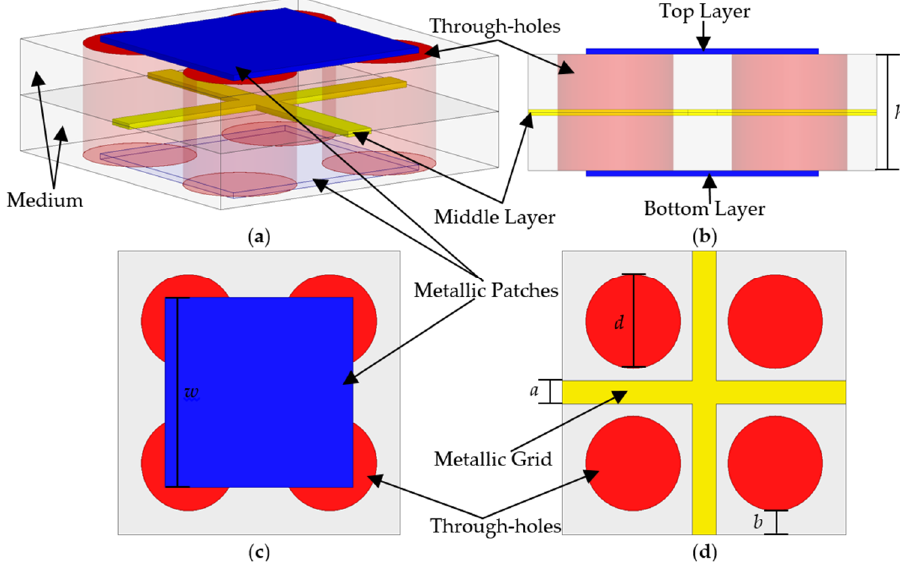
Figure 1. Perforated medium frequency selective surface (PM FSS) structure: ( a ) 3D semitransparent perspective view; ( b ) semitransparent side view; ( c ) plan view of the top and bottom layers and ( d ) plan view of the middle layer.